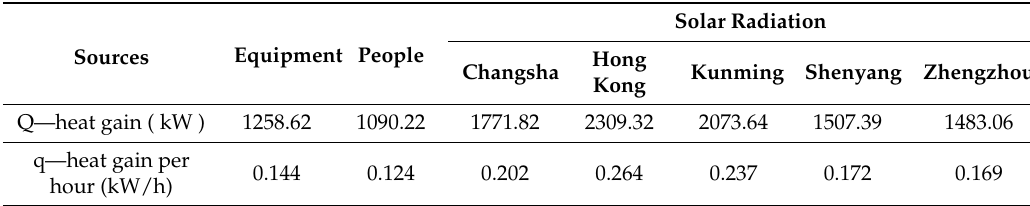
Table 5. Building heat gains in different cities.